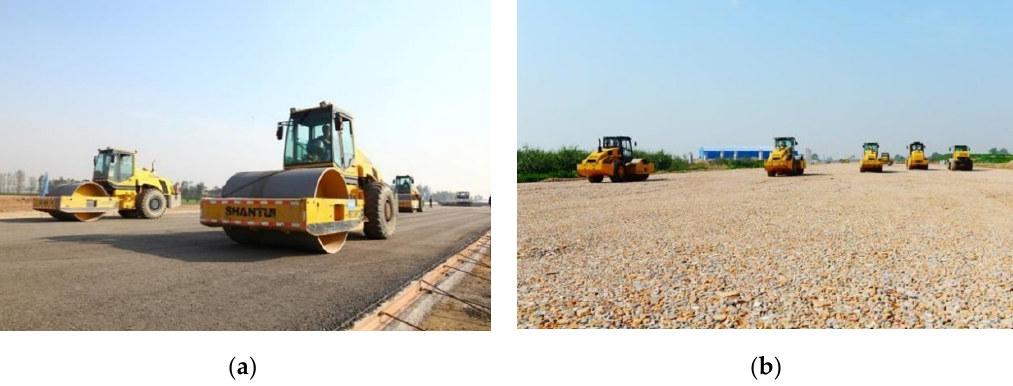
Figure 18. Upgraded recycled aggregates used in highway construction: ( a ) Base constructed using purified MRA; ( b ) Sub-base constructed by brick mixed MRA.